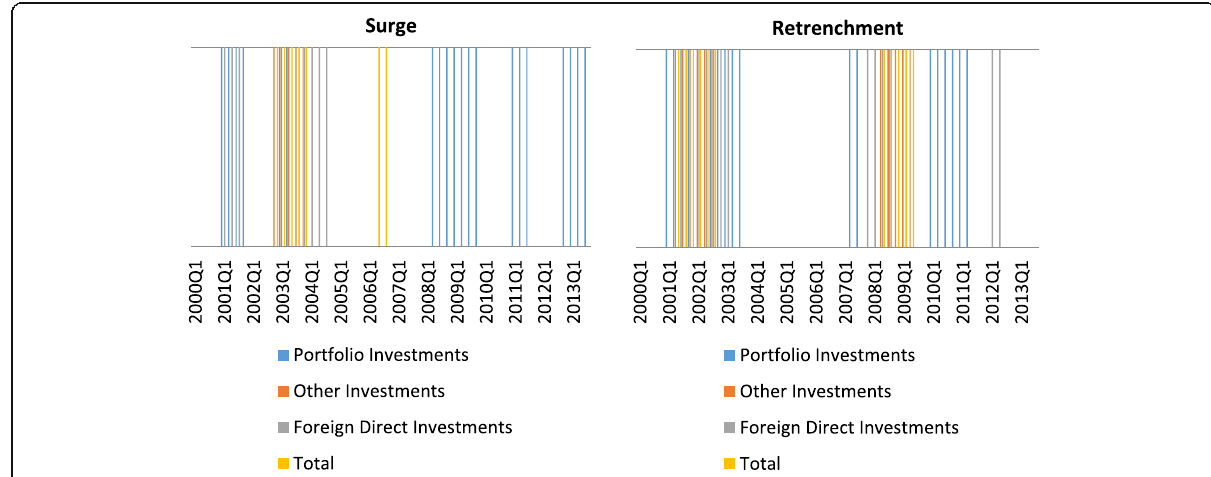
Fig. 15 Periods of strong capital inflows (surge) and low capital outflows (retrenchments) for selected categories of capital. Periods of surge or retrenchment are indicated by a line for the particular quarter. Source: IMF. Own